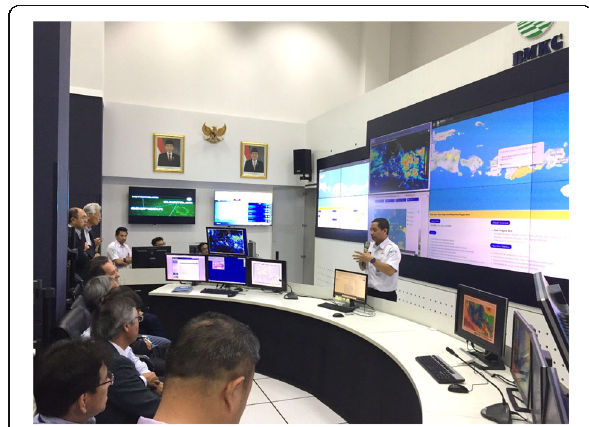
Fig. 11 BMKG officer was explaining Meteorology Early Warning System